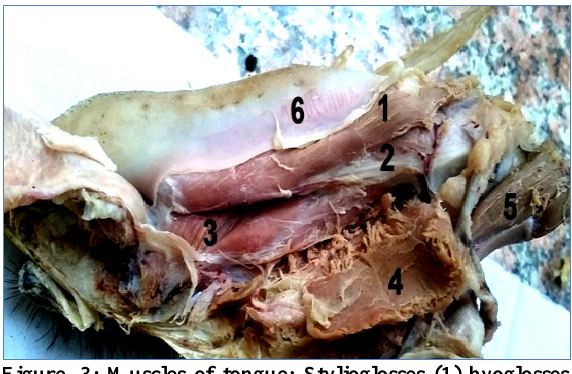
Figure, 3: Muscles of tongue: Stylioglosses (1) hyoglosses (2) genioglosses (3) geniohyodius (4) styloglosses (5) foliate papillae (6).